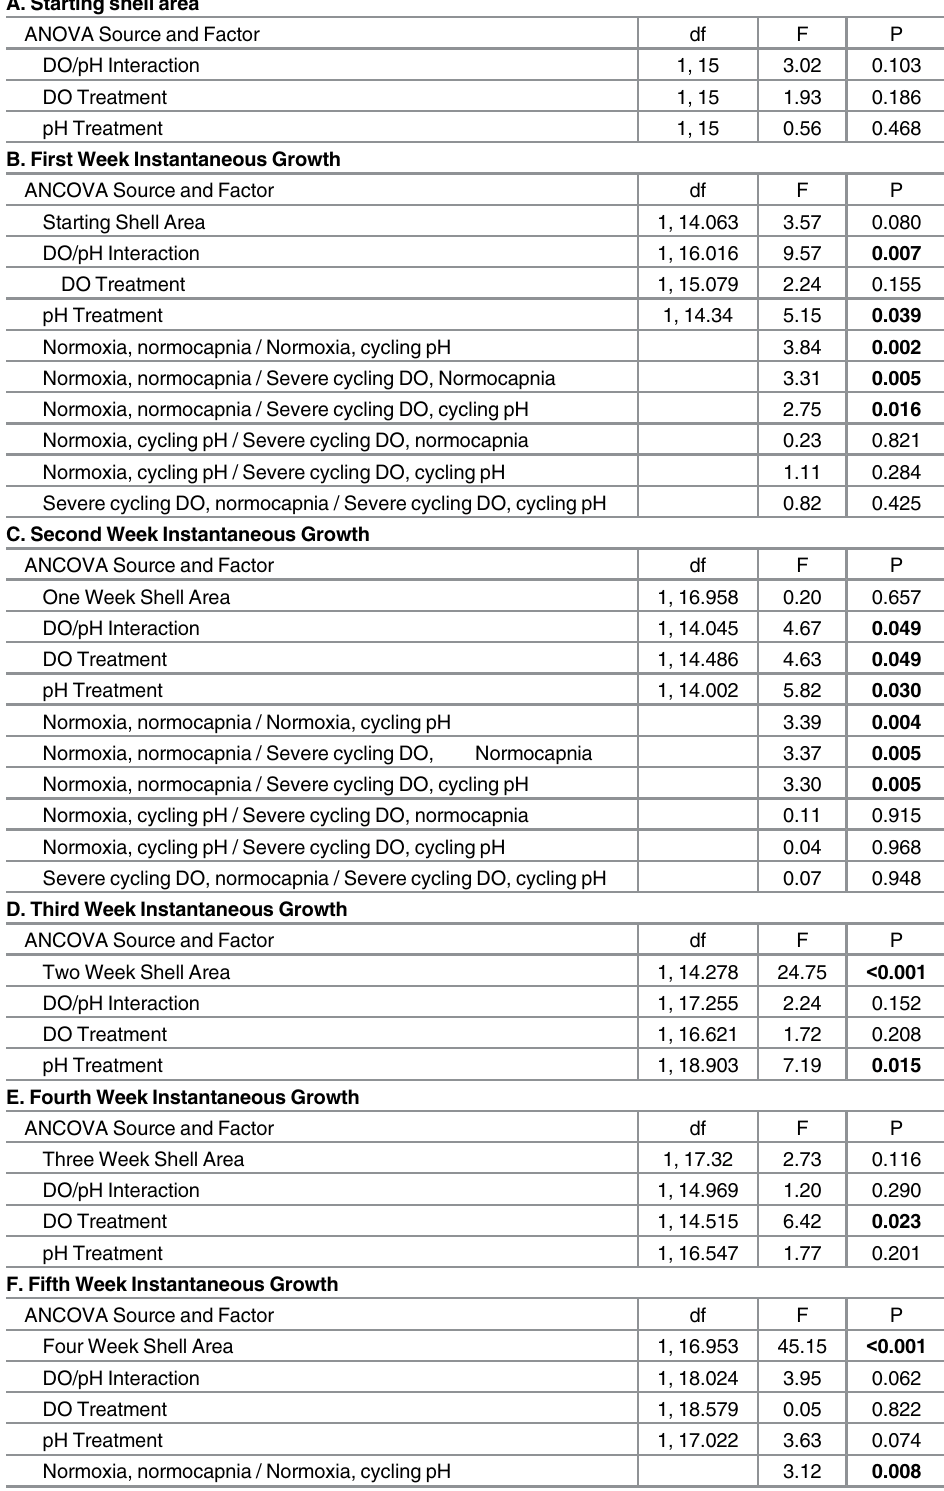
Table 10. 2015 juvenile oyster growth